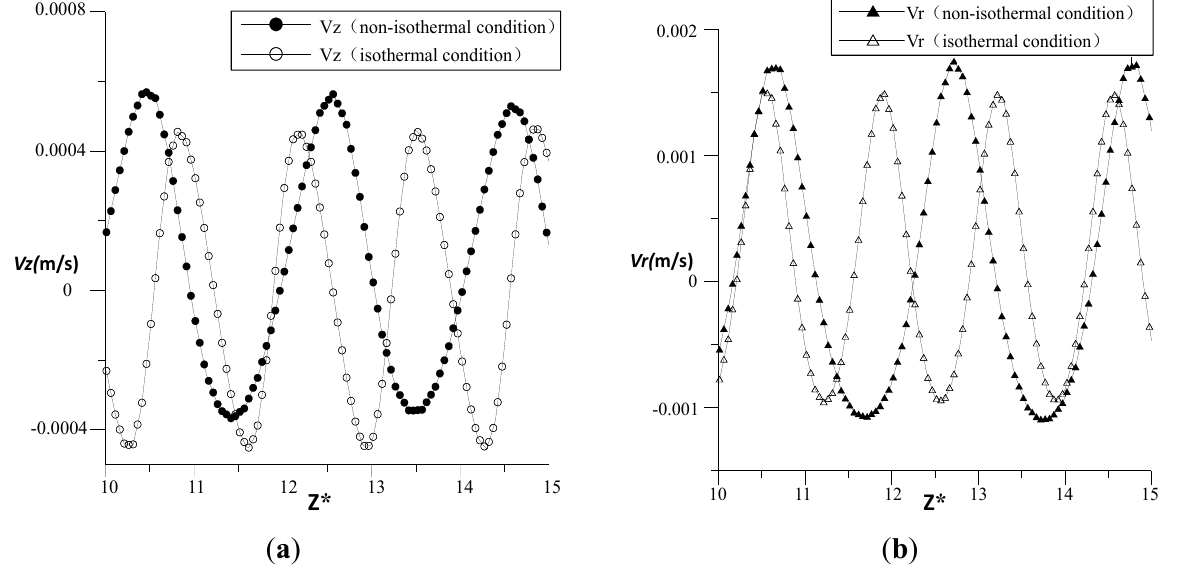
Figure 17. Axial and radial velocity profile in 6-slit model at R * = 0.5: ( a ) Axial velocity; ( b ) Radial velocity.